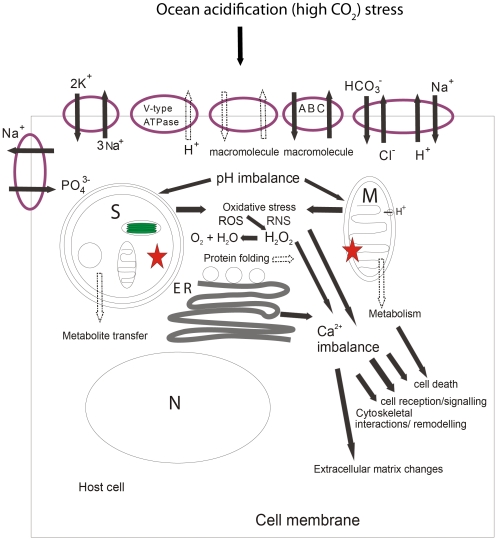
A proposed model of cellular events occurring as a result of ocean acidification.These changes lead to compromised health in Acropora millepora (reduction in symbiont cells and decreased photosynthesis and respiration). The schematic depicts an endodermal cell which contains the symbiont cell. Cellular events depicted here are likely to also occur in other cell types which do not contain symbionts, especially the acid base changes at the cell membrane. Changes in carbonate chemistry lead to changes in acid base regulation and cell membrane transporters. Acid base regulation may not be sufficient leading to acidosis within the cell. This could increase reactive oxygen species (ROS) due to a disruption (⋆) in the Symbiodinium cell (S) and/or in the coral host mitochondrion (M), which may also produce reactive nitrogen species (RNS). The overall oxidative stress and a disruption to calcium stores at the endoplasmic reticulum (ER) can lead to calcium imbalance. This in turn leads to events such as changes in the extracellular matrix, cytoskeletal remodeling, changes in cytoskeletal interactions, disruption to cell reception and signaling potential, and an increase in cell death. Moreover disruption in both the host mitochondrion and Symbiodinium cell leads to a decrease in metabolism and a decrease in metabolite transfer from the symbiont cell. In addition the disruption in the host mitochondrion can also lead to cell death. For the cell membrane transporters black arrows indicate upregulation and white arrows indicate downregulation.